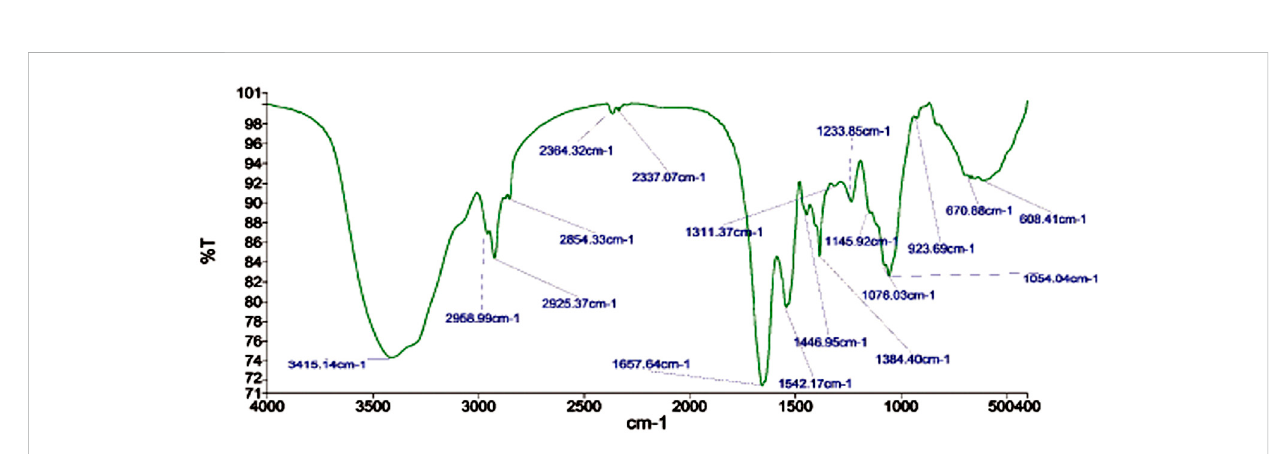
FIGURE 4 FTIR analysis of biogenic CuO